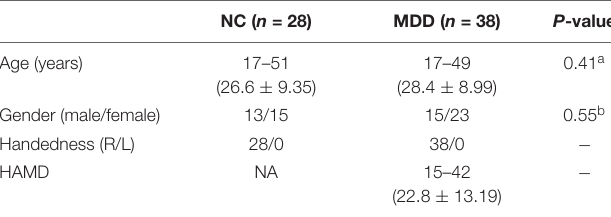
TABLE 1 | Demographics and clinical characteristics of the study